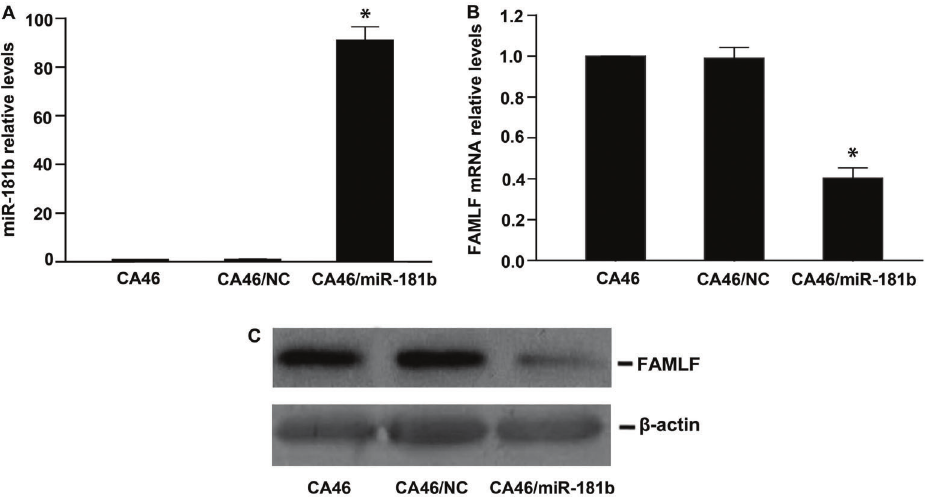
Figure 4. Detection of miR-181b transfection ef fi ciency and FAMLF expression in CA46 cells. A , miR-181b expression was increased 91 times after transfection. B , FAMLF mRNA expression was reduced by 40% after transfection. C , FAMLF protein expression was reduced by 14% after transfection. CA46 group was used as a control (NC) and was normalized. Data are reported as means ± SD (n=6). *P o 0.01, CA46/miR-181b compared to CA46 and CA46/NC